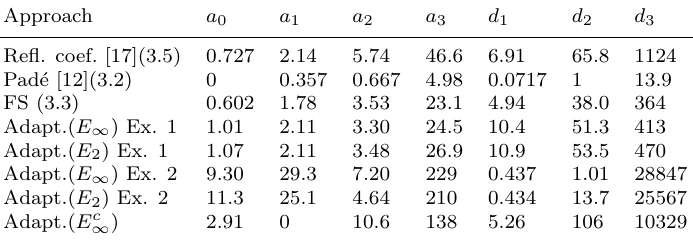
Table 1. Coefficients obtained with different approaches